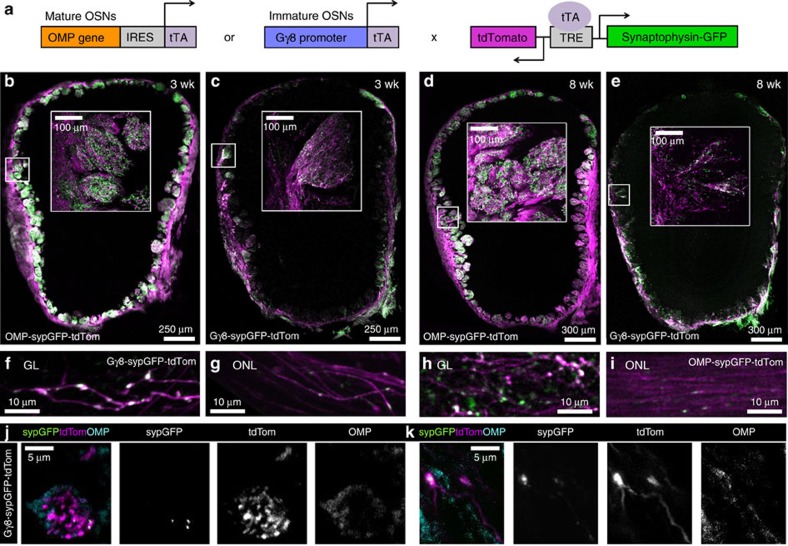
Specific labelling of immature and mature OSN axons in the OB.(a) Schematic representation illustrating generation of transgenic lines expressing tdTom and sypGFP specifically in either immature or mature OSNs using the tTA system. (b,c) Widefield fluorescence images of coronal sections through OBs of 3-week-old OMP-sypGFP-tdTom (b) and Gγ8-sypGFP-tdTom (c) mice. Inset: maximum intensity projections of confocal z-stacks for boxed regions. (d,e) As b,c but for 8-week-old mice. Note difference in scale bar for main images. (f,g) Two-photon images of immature OSN axons in glomerular (f) and outer nerve (g) layers of a Gγ8-sypGFP-tdTom mouse. (h,i) As f,g for an OMP-sypGFP-tdTom mouse. (j,k) Confocal images of anti-OMP staining in the GL of the OB of Gγ8-sypGFP-tdTom mice, showing little co-expression of OMP in Gγ8+ OSN axons.